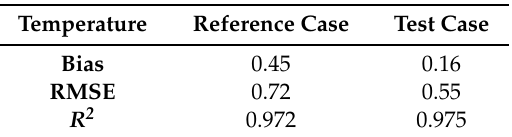
Figure 6. Comparison of mean transect salinity and temperature from observations during 12 cruises from 2 December 2002 to 7 August 2007 and corresponding values from models without (upper plots) and with (lower plots) satellite-derived Kd and rainfall. The legend shows the dates of cruises. In the lower plots, smaller mean bias and root mean square error (RMSE) and Model Observed i i n = 1 larger coefficient of determination ( R 2 ) were obtained using satellite data. The lines represent the 1:1 line. Table 1. Comparison of mean transect temperature from observations and corresponding values from model without (reference case) and with (test case) satellite-derived Kd and rainfall. Unit for bias and root mean square error (RMSE) are °C.